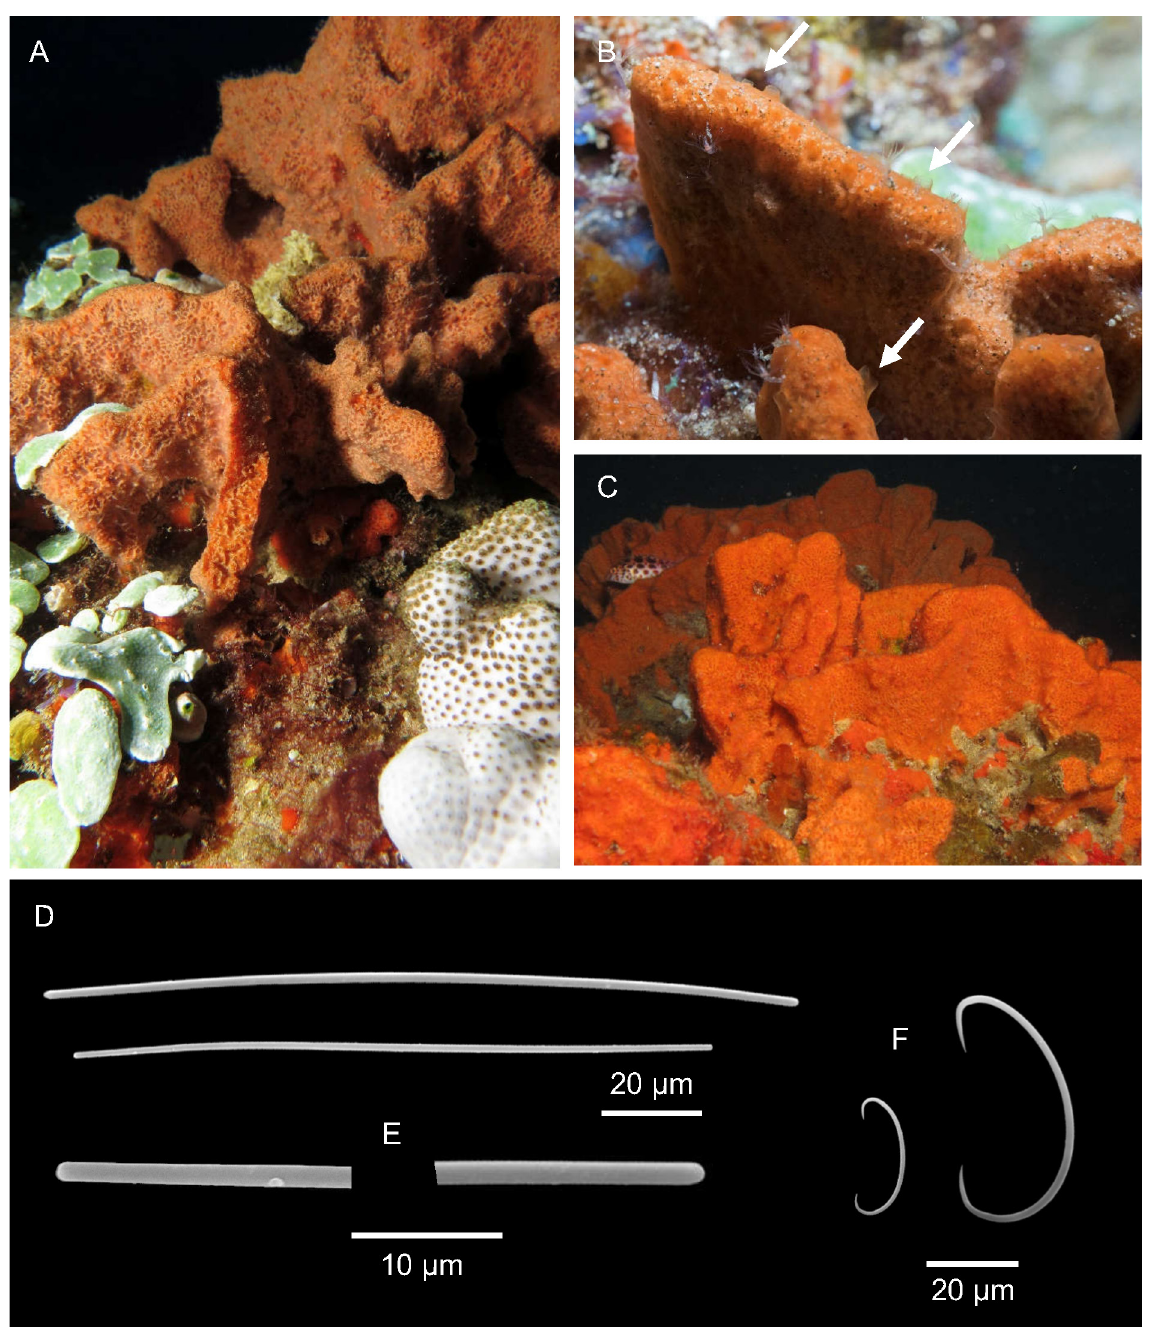
Fig. 18. Chondropsis lamella (Lendenfeld, 1888). A–C . Specimens in situ , respectively PO32, PO79 and PdO18c; in B the arrows point the slightly elevated oscules. D . Strongyles. E . Magnifications of the tips. F .